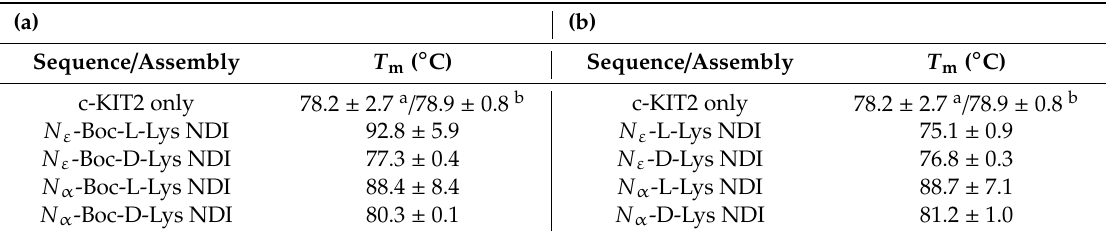
Table 1. The T m values of c-KIT2 only compared to the T m of ( a ) c-KIT2-Boc-protected-NDIs and ( b ) c-KIT2-deprotected-NDIs as determined from VT CD studies.